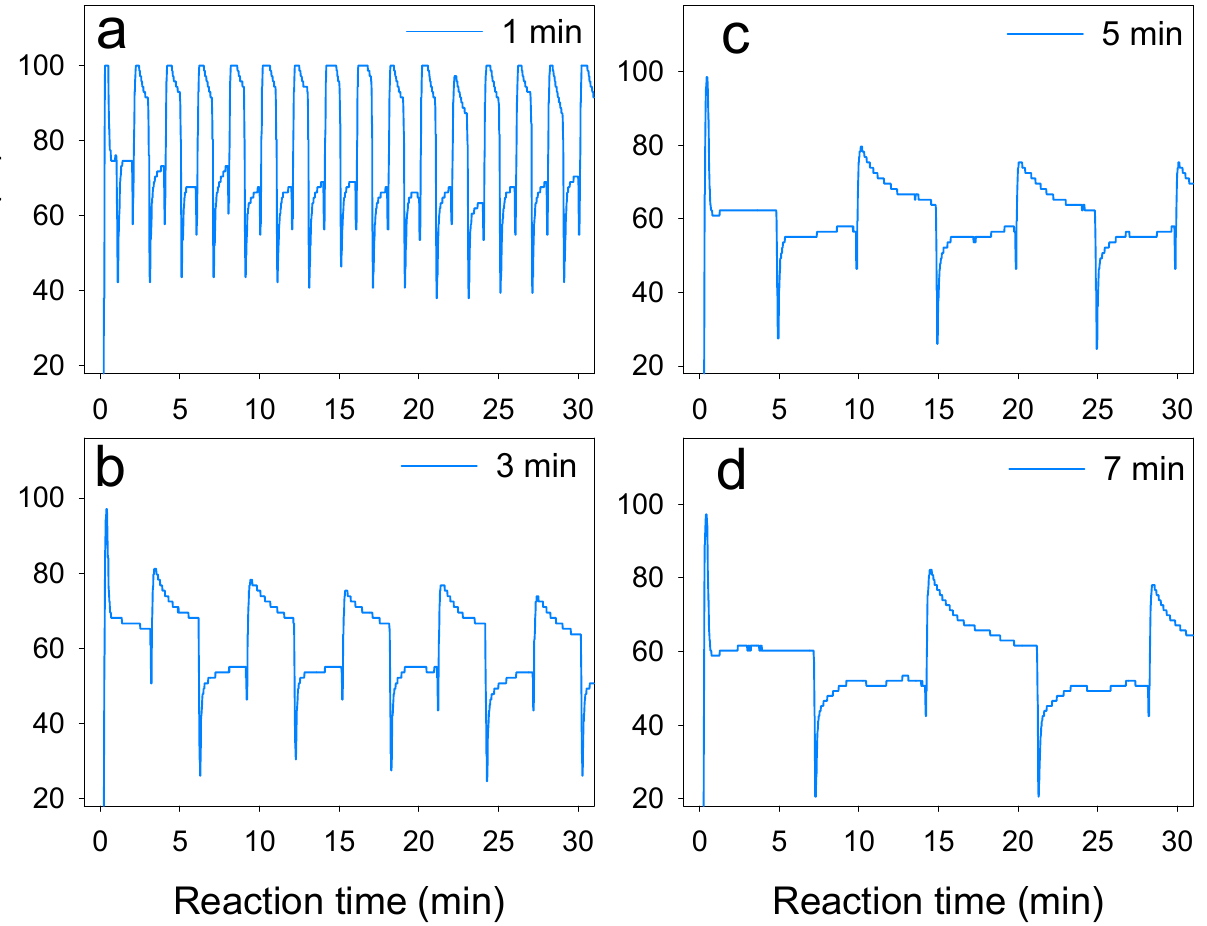
Figure 9. Dynamic of methane conversion of La 0.8 Sr 0.2 MnO 3 catalyst with different switch times. Start-up conditions: reaction temperature: 800 °C, methane inlet concentration: 0.7%, methane inlet velocity: 1.2 m 3 /h. The switch time were ( a ) 1 min, ( b ) 3 min, ( c ) 5 min, ( d ) 7 min.